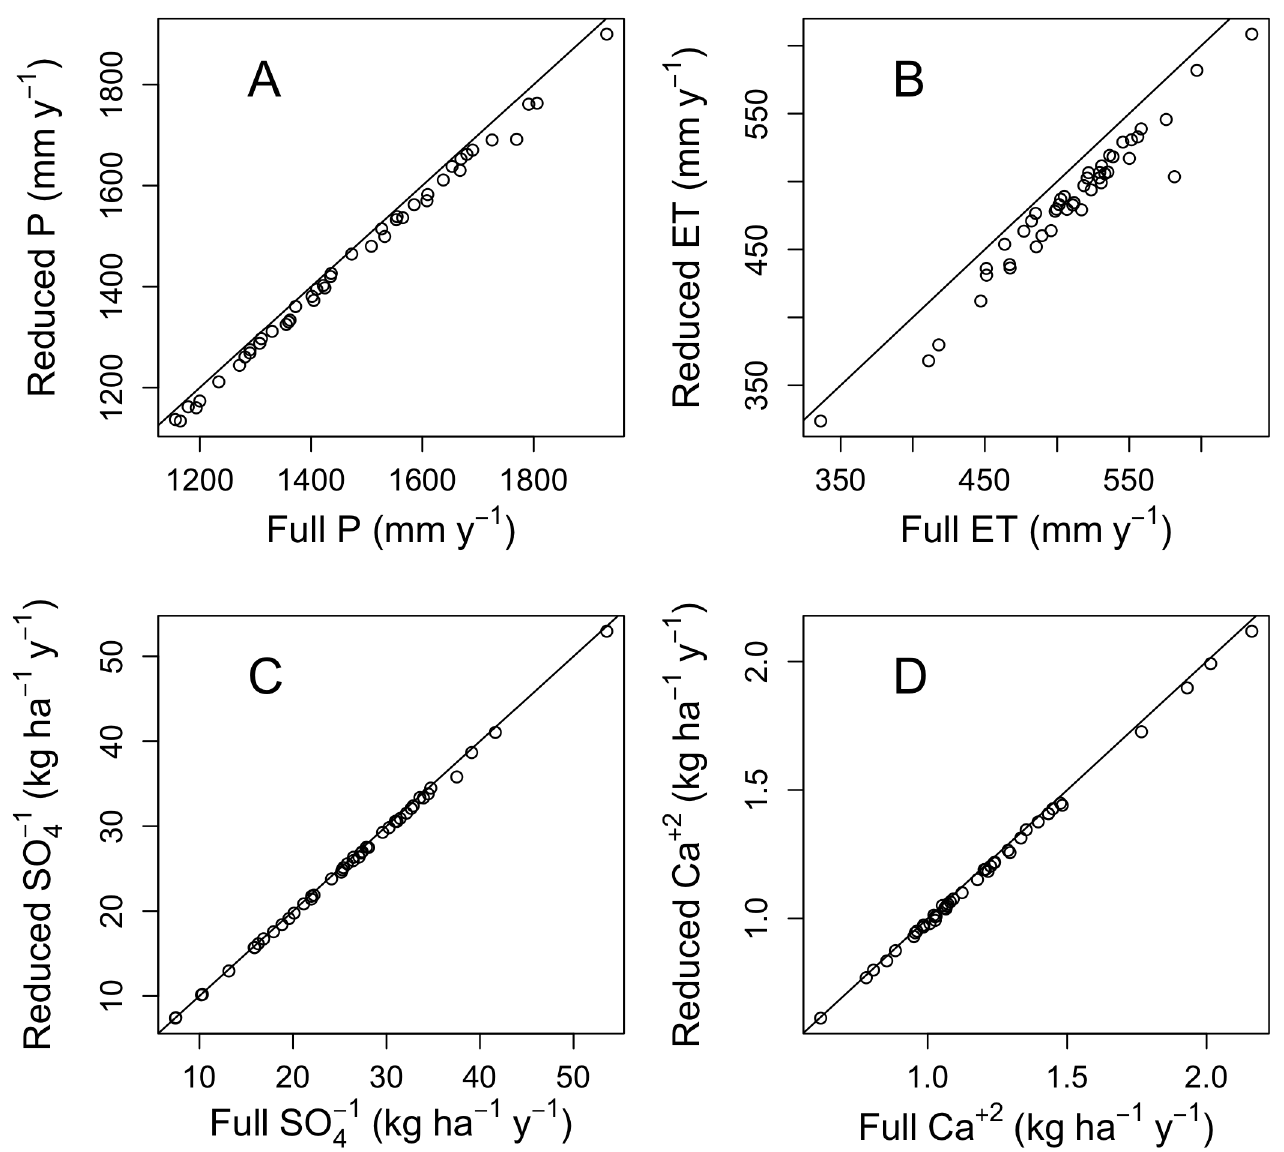
Fig 8. Estimates of annual precipitation (P), evapotranspiration (ET), sulfate bulk deposition, and calcium bulk deposition for W6 based on the reduced precipitation monitoring scheme compared to estimates based on the full monitoring network.